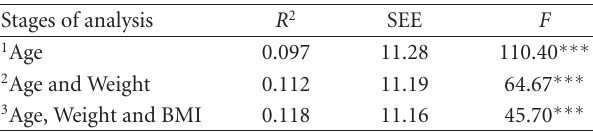
Table 5: Stepwise regression analysis summary for Diastolic Blood Pressure (DBP) showing changes in multiple regression coe ffi cient of determination ( R 2 ) with addition of di ff erent